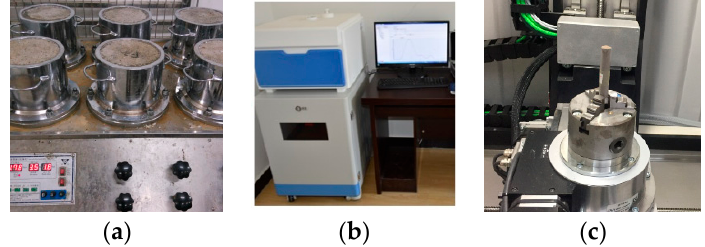
Figure 4. CPB block permeability and porosity testing. Equipment for ( a ) permeability, ( b ) NMR, and ( c ) CT analyses.